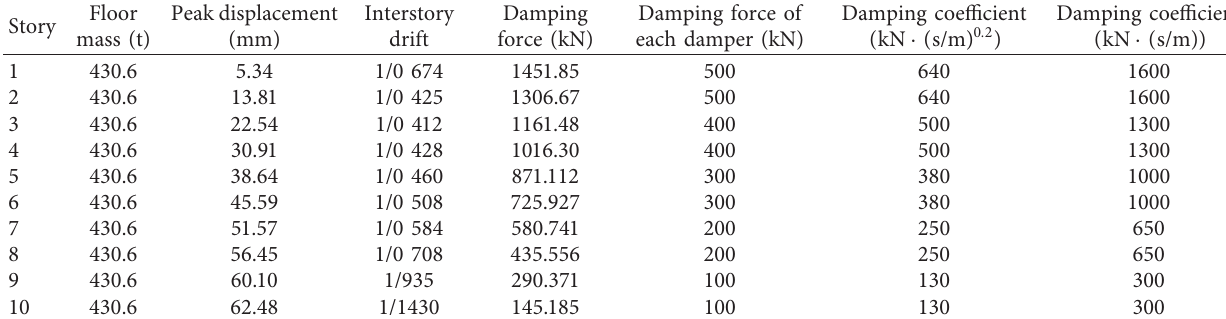
Table 2: Design information of viscous